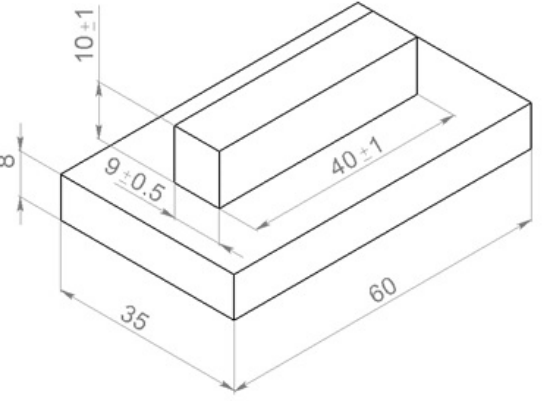
Figure 3. The dimensions (in mm) of the standard model sample and the substrate. The obtained data were also used to determine the percentage of non-fusion in the macrosections. An image processing program was written in the Matlab software